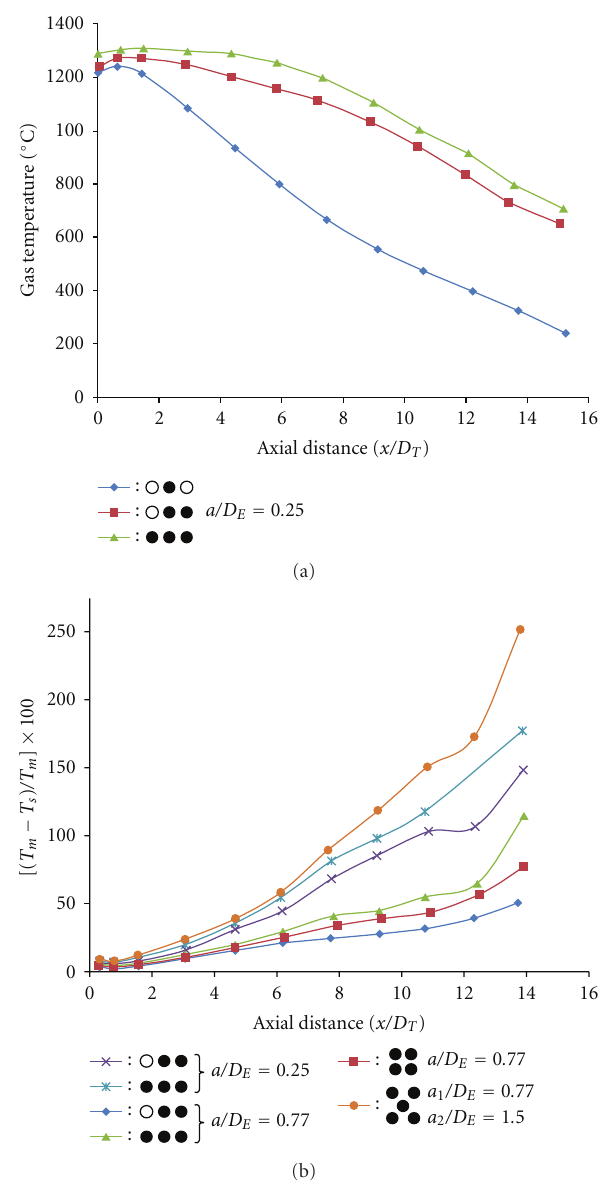
Figure 7: (a) E ff ect of nearby burners on flame temperature from [119]. D T is throat diameter, D E is exit diameter, a is separation distance, T m is merged flame temperature, and T s is single flame temperature. (b) Temperature compared to independent flame for varying axial distance along flame, number of burners, burner arrangement, and burner spacing from